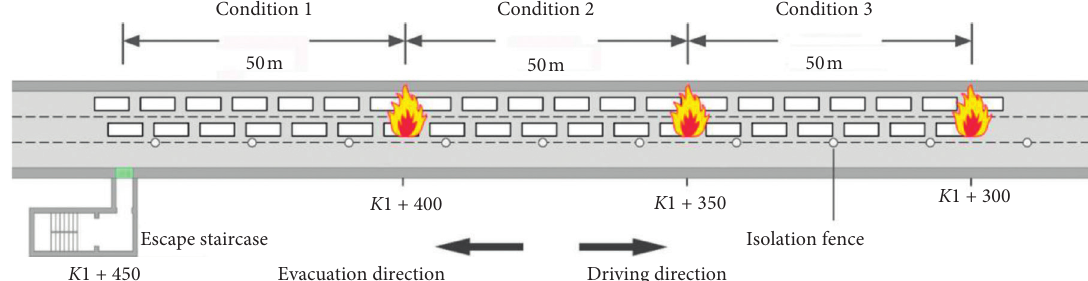
Figure 5: Evacuation experiment scenarios under different spacing of escape staircase.